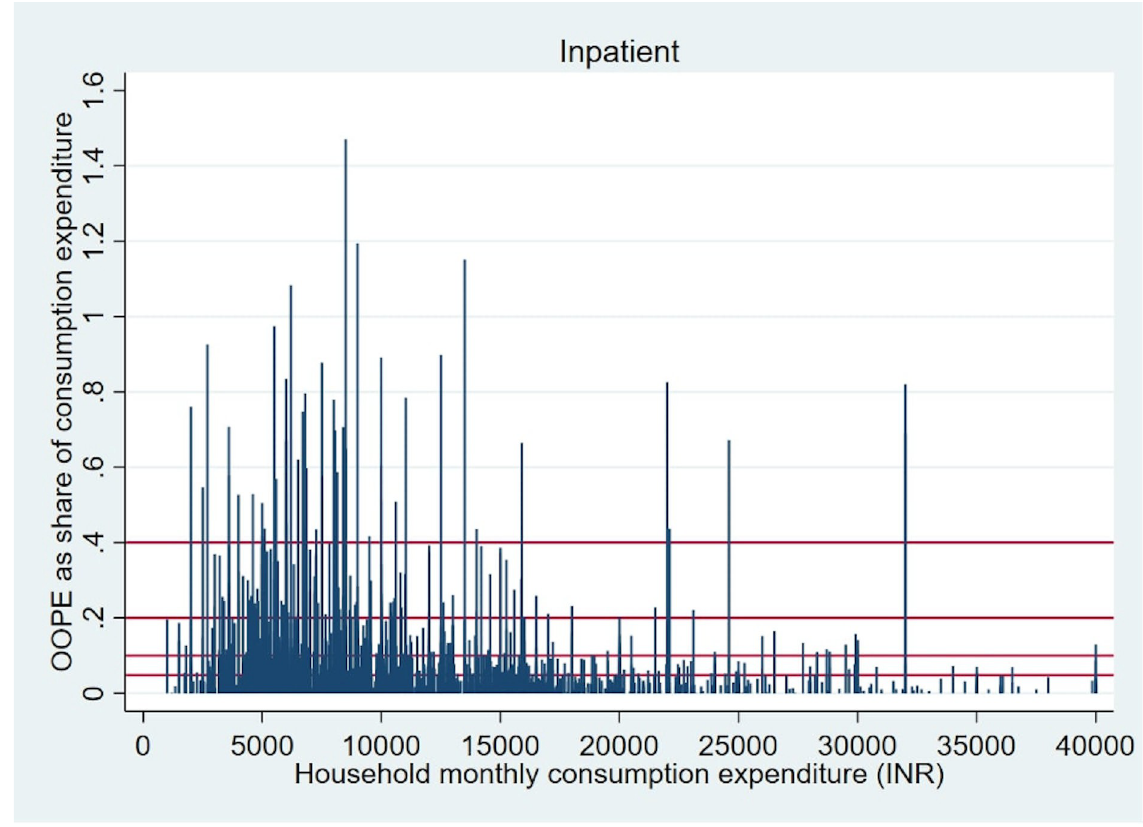
Fig 2. Hospitalisation OOPE on childhood infections as a share of per capita monthly consumption expenditure of households.